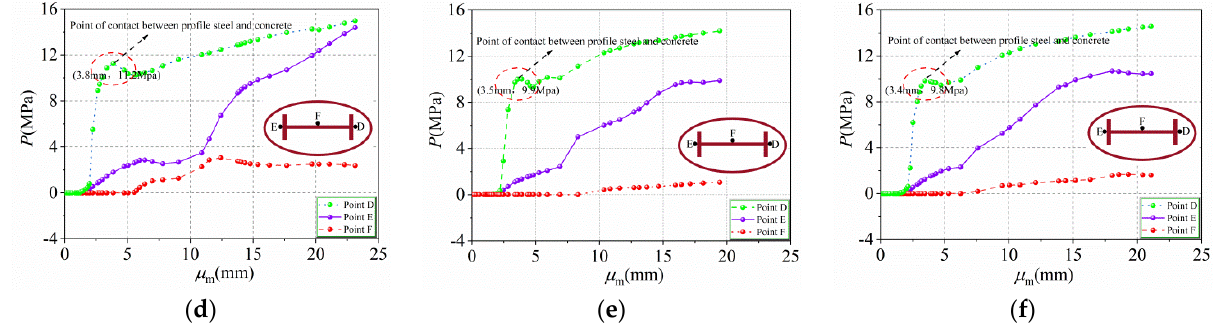
Figure 17. Contact stress curve of three typical specimens: ( a ) HUCFEST−18 contact stress curve between steel tube and concrete; ( b ) HUCFEST−19 contact stress curve between steel tube and concrete; ( c ) HUCFEST−20 contact stress curve between steel tube and concrete; ( d ) HUCFEST−18 contact stress curve between H-shape steel and concrete; ( e ) HUCFEST−19 contact stress curve between H-shape steel and concrete; ( f ) HUCFEST−20 contact stress curve between H-shape steel and concrete.